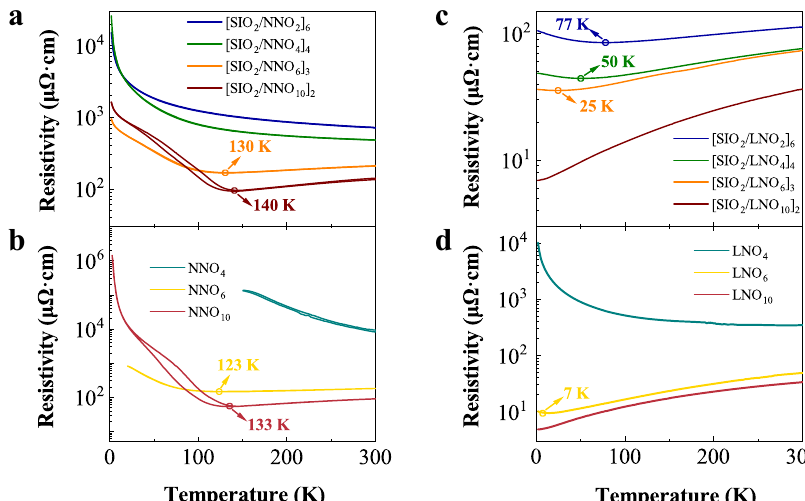
Fig. 6 Transport characteristics. Temperature dependent resistivity ( ρ (cid:1) T ) curves of a the [(SrIrO 3 ) 2 /(NdNiO 3 ) k ] l ( k = 2, 4, 6, 10) superlattices, abbreviated as [SIO 2 /NNO k ] l , b the NNO k ( k = 4, 6, 10) fi lms; c the [(SrIrO 3 ) 2 /(LaNiO 3 ) k ] l ( k = 2, 4, 6, 10) superlattices, abbreviated as [SIO 2 /LNO k ] l , and d the LNO k ( k = 4, 6, 10) fi lms, where the k = 2, 4, 6, 10 superlattice samples are represented by blue, green, orange and brown, respectively and the k = 4, 6, 10 pure fi lm samples are represented by cyan, yellow and red, respectively. The metal-insulator transition temperature is indicated by an open Figure 6c, d shows ρ (cid:1) T curves of the [SIO 2 /LNO k ] l super- lattices and LNO k thin fi lms, respectively. Bulk LNO is metallic, but insulating behavior and upturn of ρ (cid:1) T curve are often